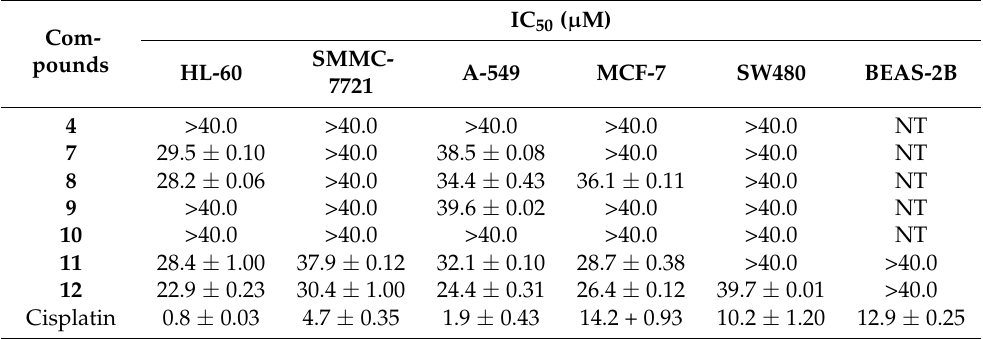
Table 1. In vitro anticancer activity (IC 50 , µ M) of glucoside derivatives